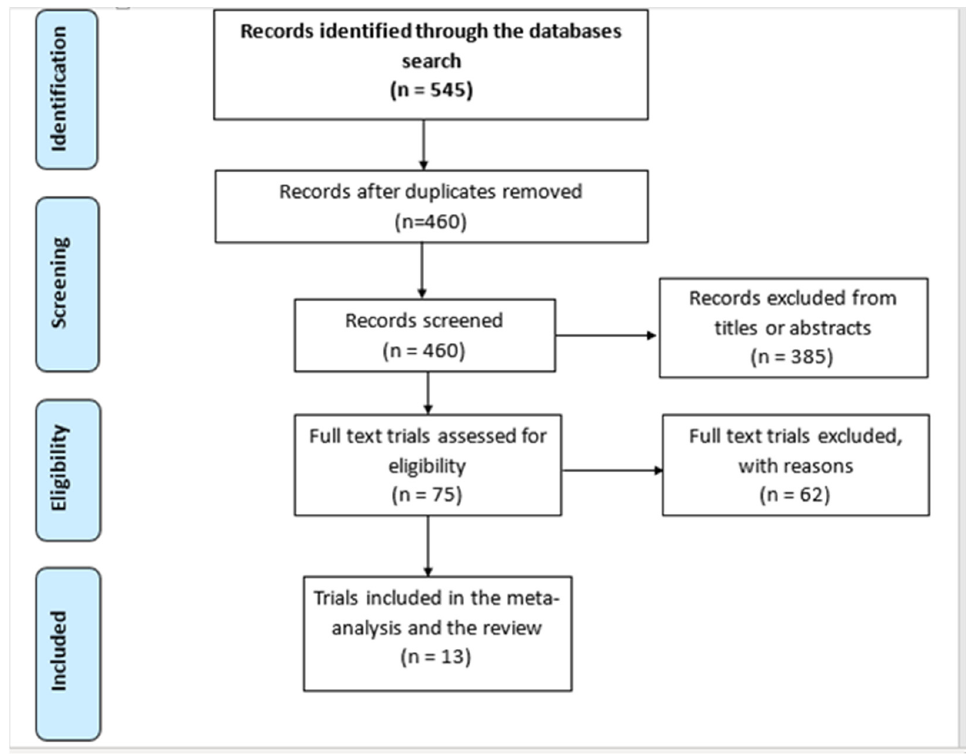
Figure 1. The PRISMA flow-chart for the search records and the included trials.